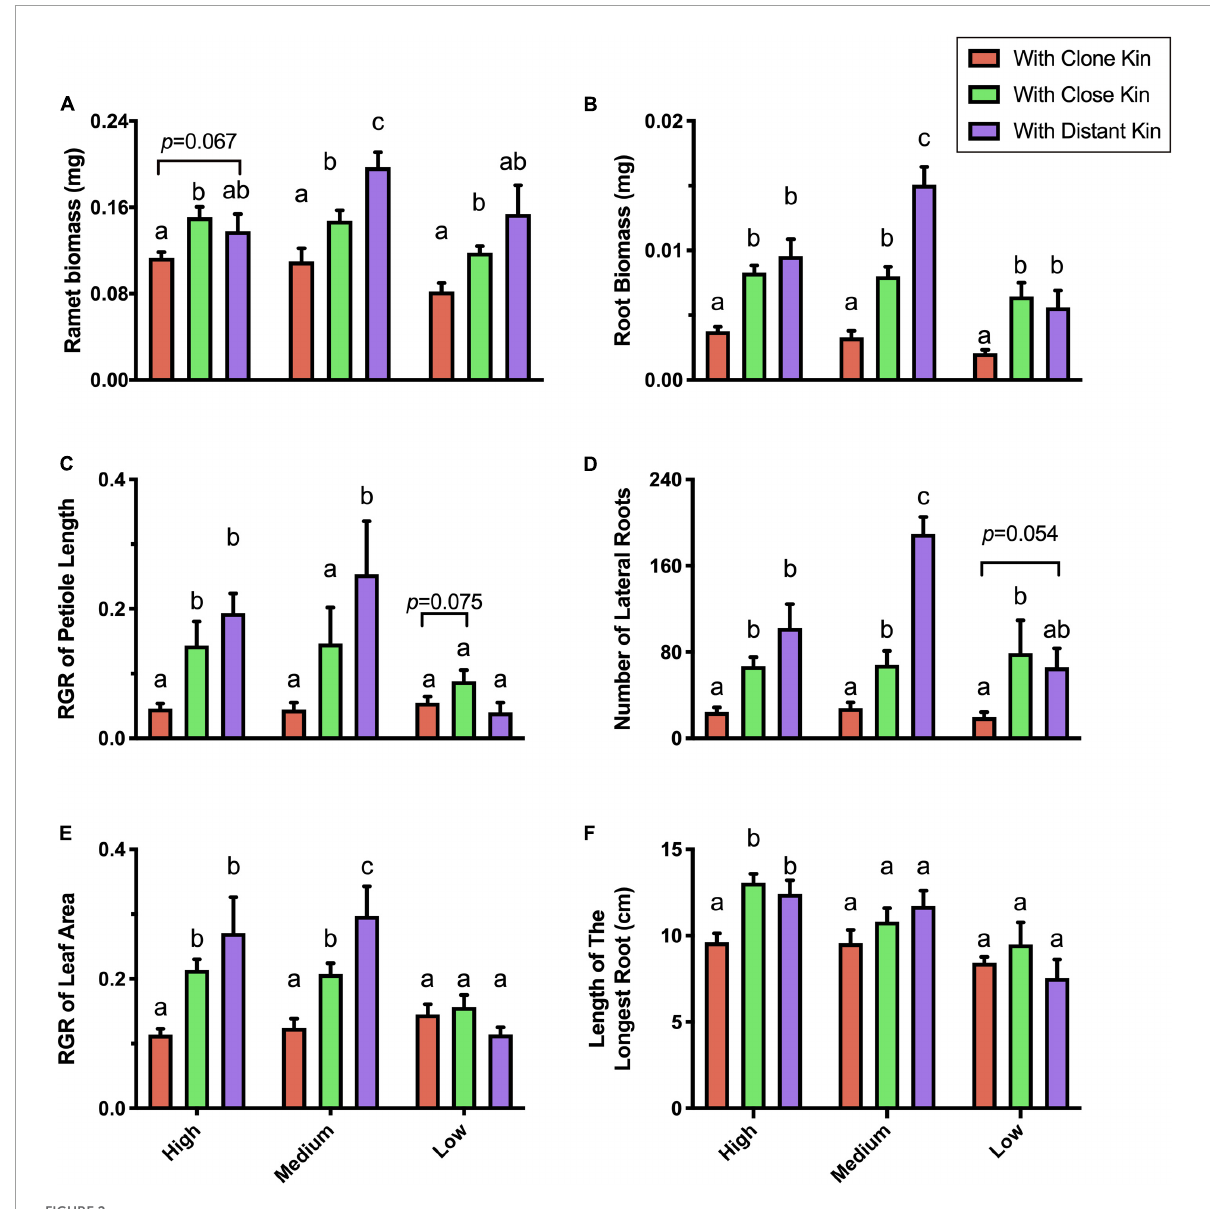
FIGURE2 Competitive traits of G. longituba ramet response to different genetic related kins under different nutrient levels. (A) ramet biomass, (B) root biomass, (C) RGR of petiole length, (D) number of lateral roots, (E) RGR of leaf area, and (F) Length of the longest root. The different genetic related kins are either Clone Kin (target ramet and its neighbor have same genes), Close Kin (target ramet and its neighbor have close genetic distance) or Distant Kin (target ramet and its neighbor have the farthest genetic distance). The nutrient levels are high (100% Hoagland), medium (25% Hoagland), and low (6.25% Hoagland). Bars with different letters mean significant differences at p <